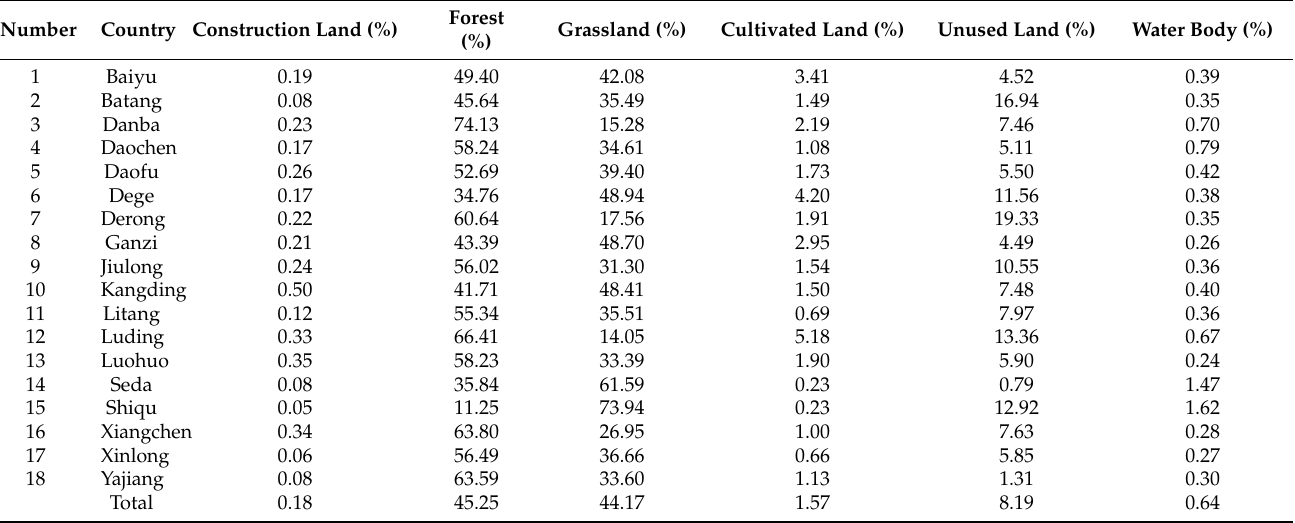
Figure 3. Landscape type map of the study area. Note: The county numbers in Figure 3 correspond to the numbers in Table 4. Table 4. Land use in each county of Ganzi Prefecture.